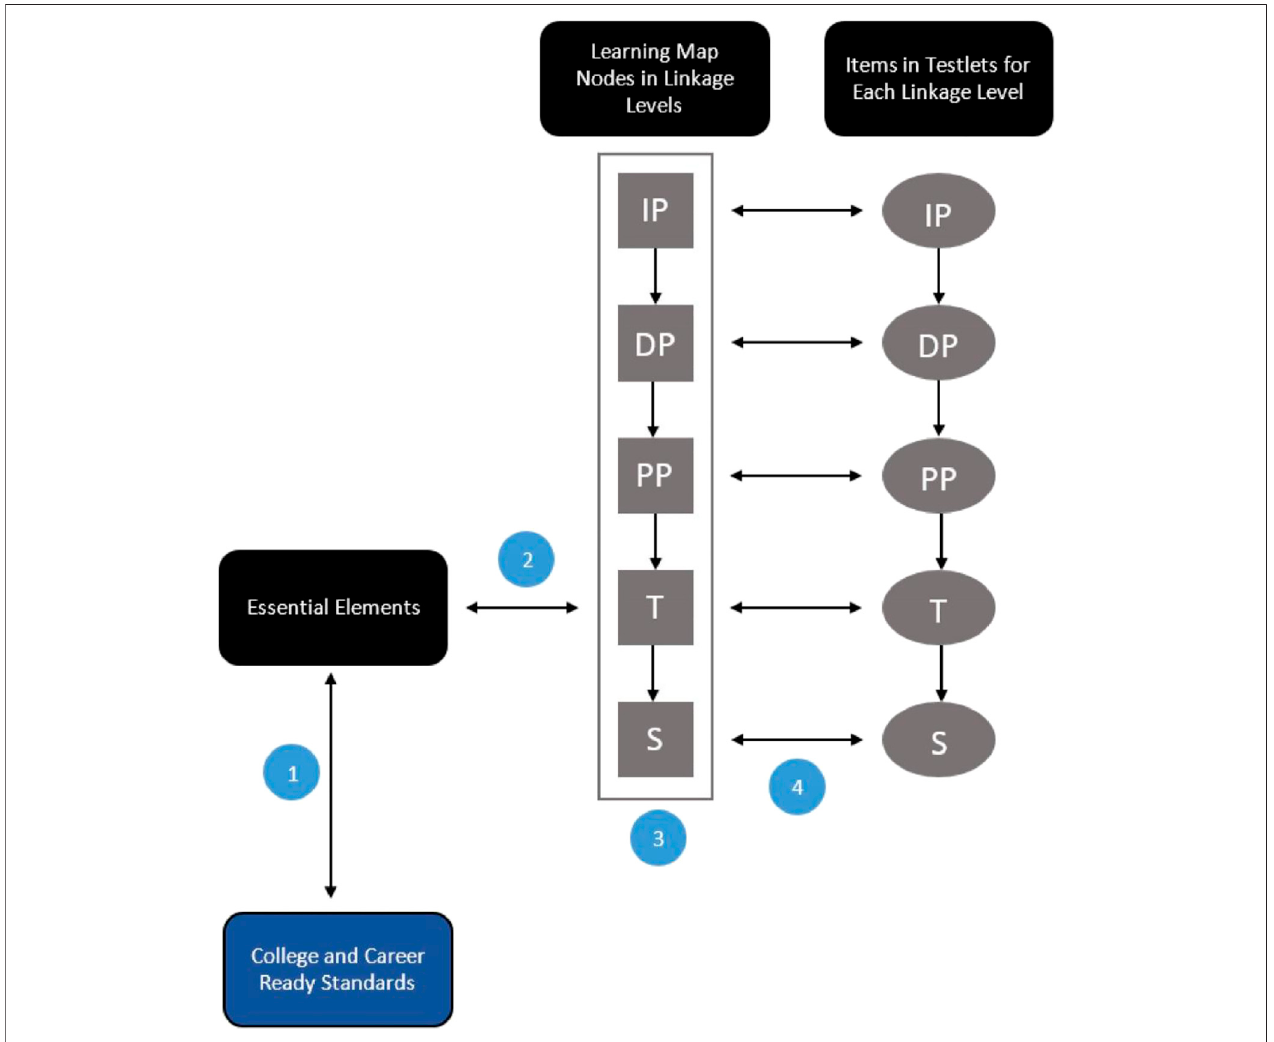
FIGURE 2 | Content relationships in the DLM assessment system. Source: DLM Consortium, 2016. Numbers indicate relationships evaluated in alignment studies. Linkage level abbreviations: initial precursor — IP, distal precursor — DP, proximal precursor — PP, target — T, successor —